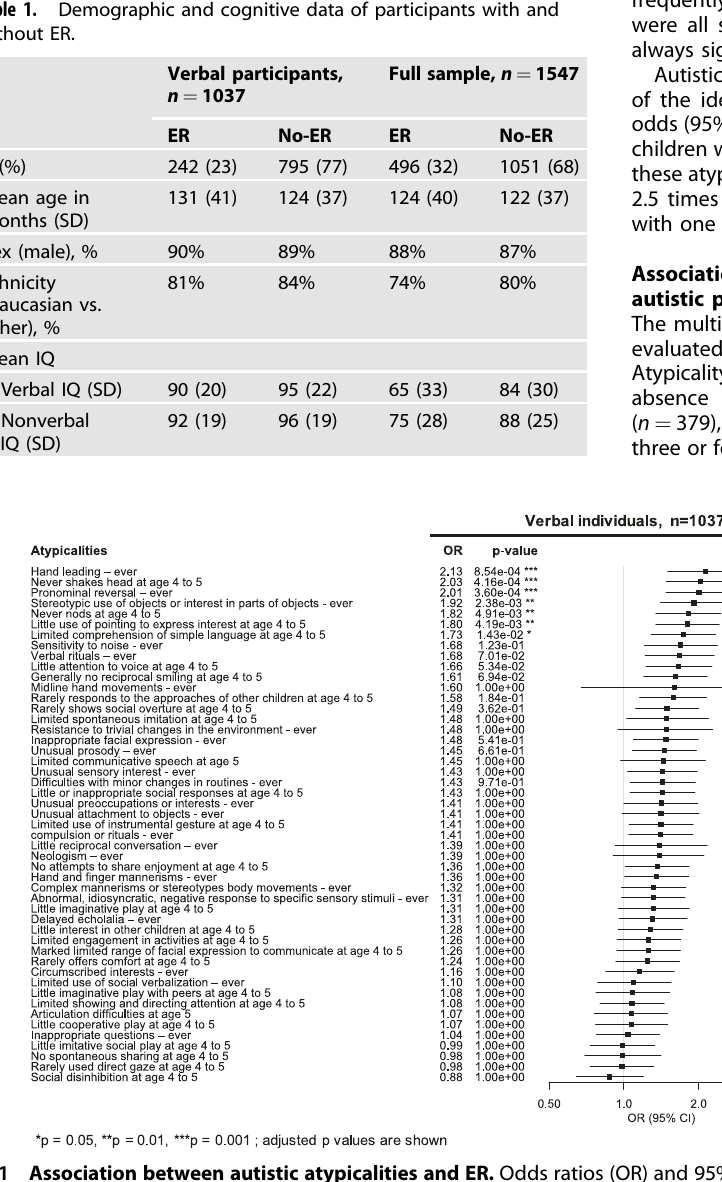
Fig. 1 Association between autistic atypicalities and ER. Odds ratios (OR) and 95% con fi dence intervals are shown. Signi fi cance level is 0.05 after Bonferroni correction; adjusted p values are